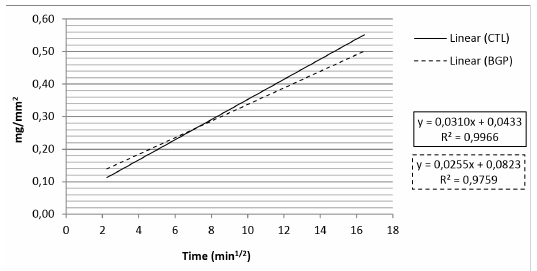
Figure 10. Linear regression for capillarity absorption versus square root of time, during